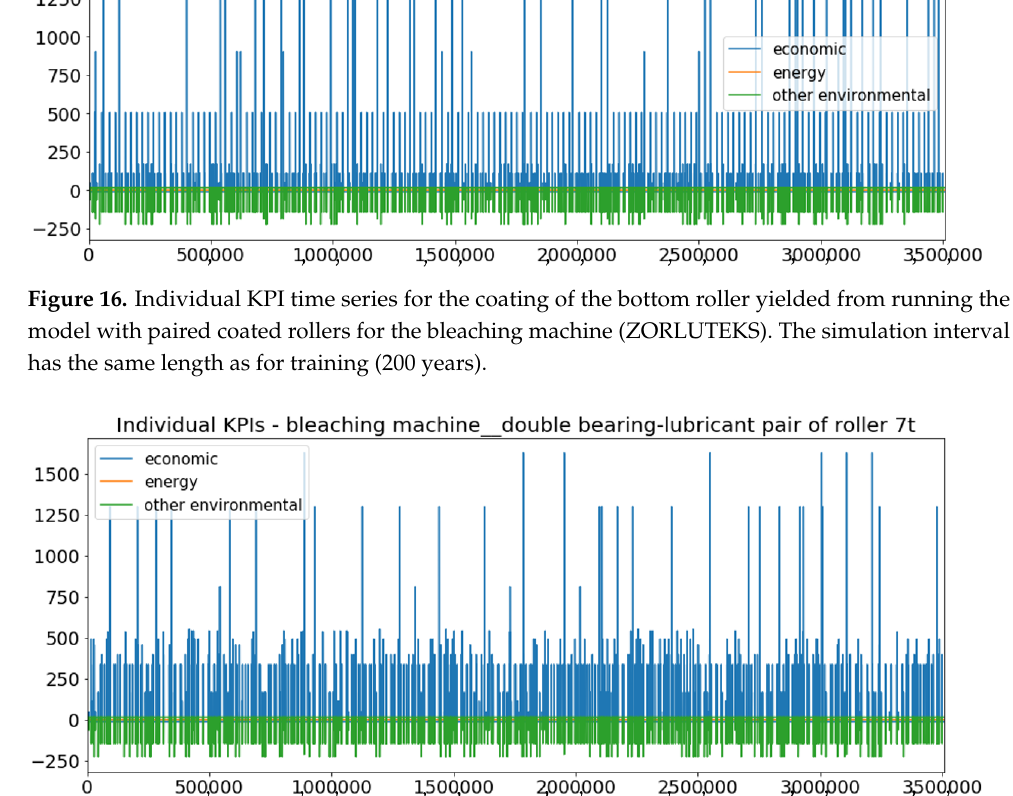
Figure 17. Individual KPI time series for the double bearing-lubricant pair of the top roller yielded from running the model with paired coated rollers for the bleaching machine (ZORLUTEKS). The simulation interval has the same length as for training (200 years).